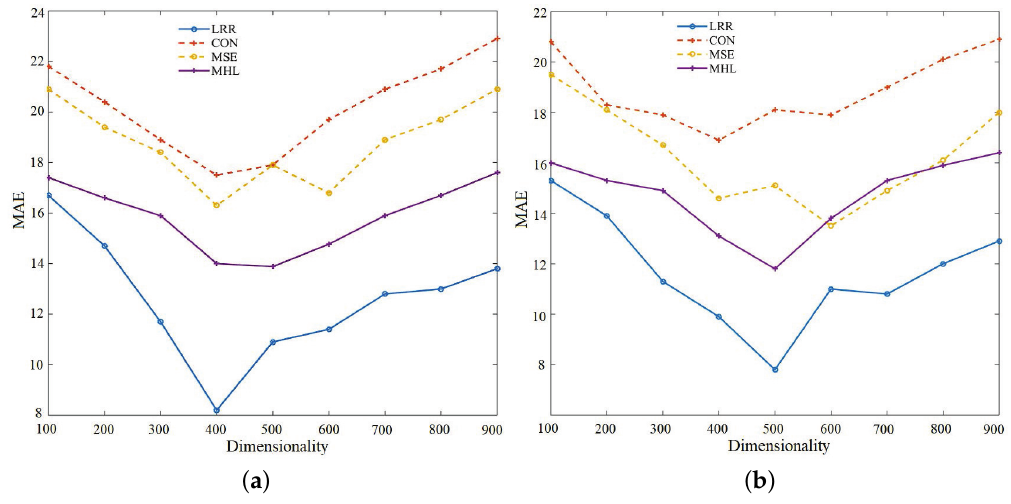
Figure 5. Different feature fusion methods. ( a ) Results of IMDB; ( b ) Results of